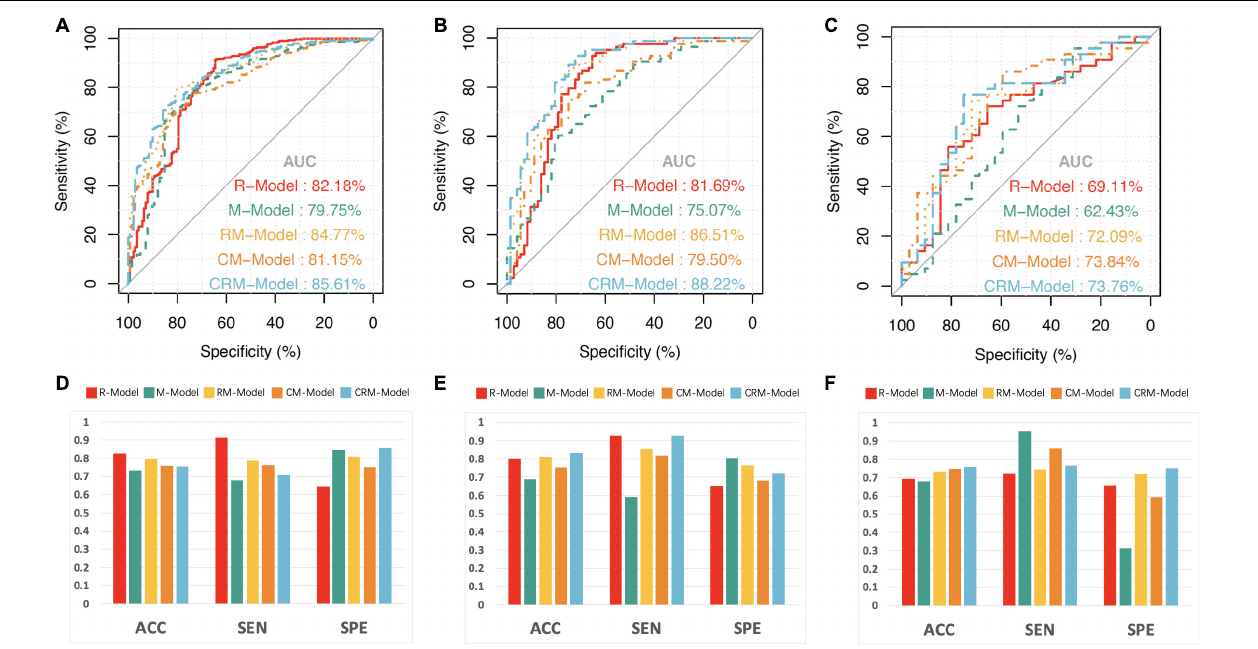
FIGURE 2 | The receiver operating characteristic (ROC) curves, accuracy, sensitivity, and specificity of the radiomics model (R-model), morphological model (M-model), radiomics-morphological model (RM-model), clinical-morphological model (CM-model); and clinical-radiomics-morphological model (CRM-model). The ROC curves of the three models in training (A) , temporal validation (B) , and external validation datasets (C) . The accuracy, sensitivity, and specificity of the three models in the training (D) , temporal validation (E) , and external validation datasets (F) . ACC, accuracy; SEN, sensitivity; SPE,